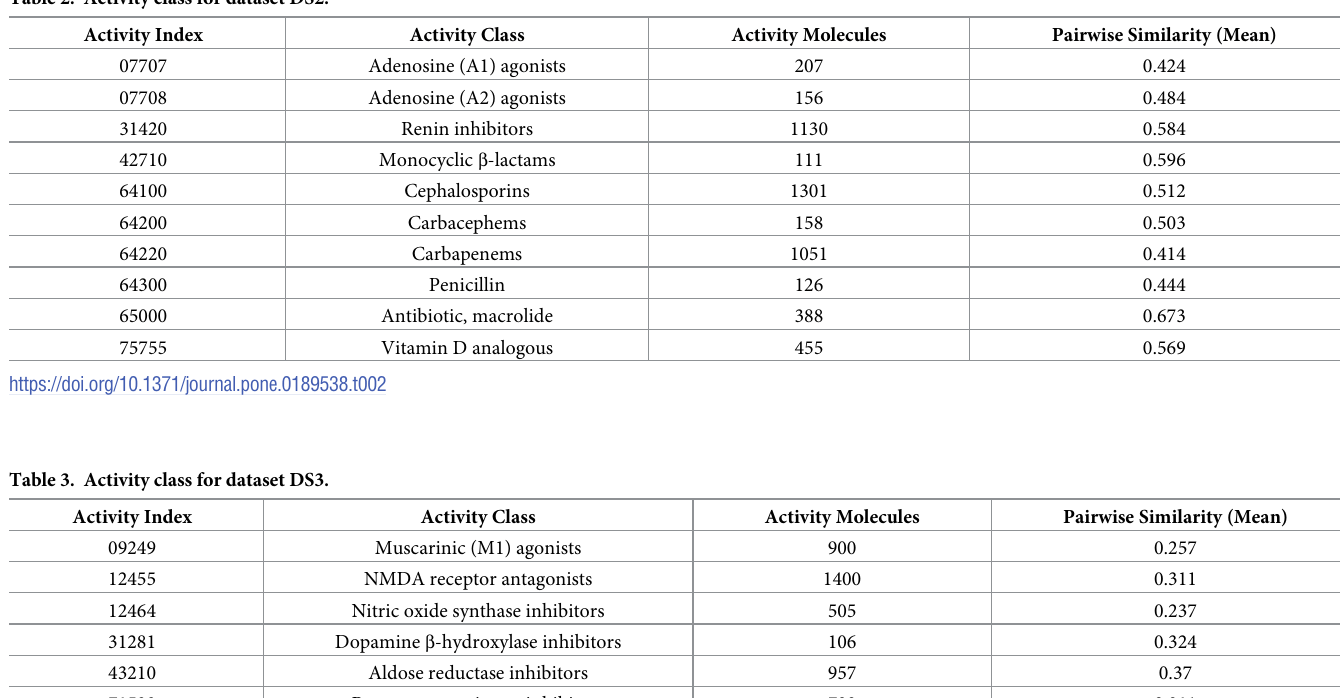
Table 2. Activity class for dataset